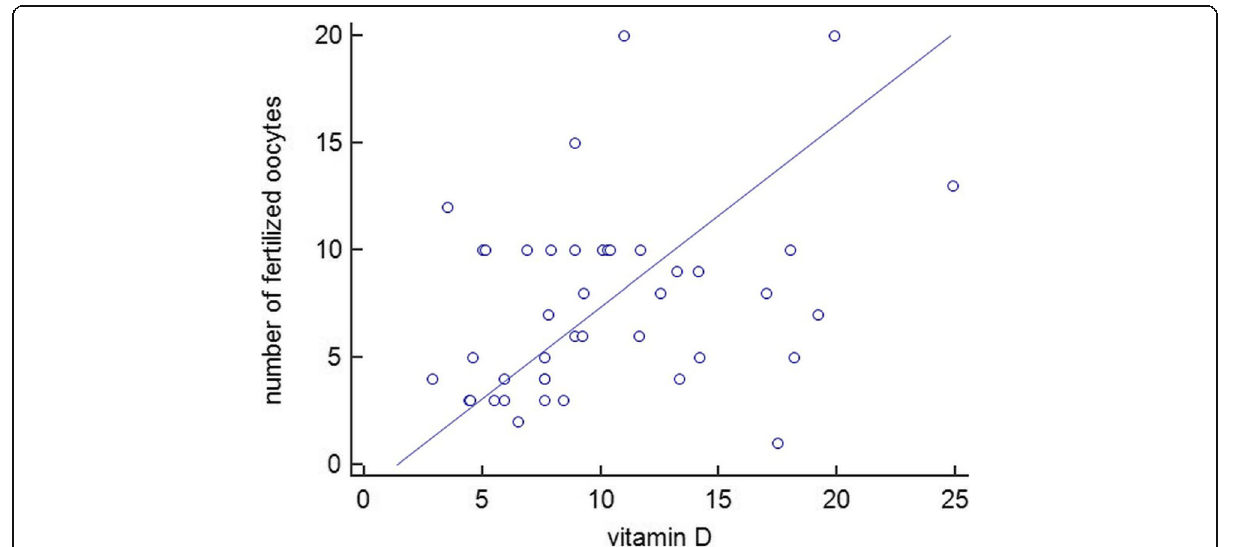
Fig. 3 Correlation of serum 25 (OH) D vitamin level to the number of fertilized